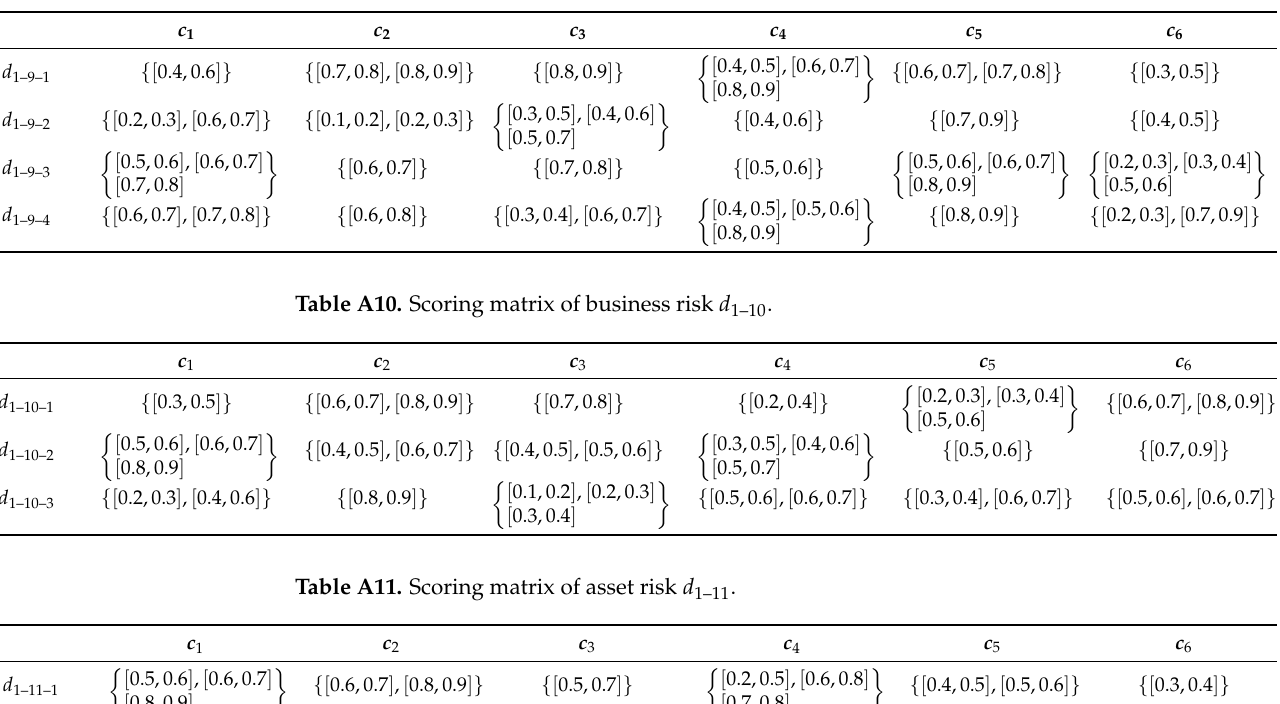
Table A9. Scoring matrix of solvency risk d 1–9 .